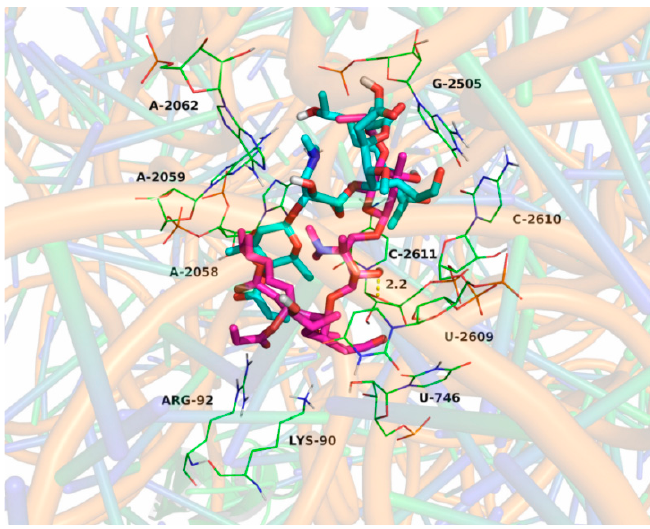
Figure 4. Overlapped conformation of the midecamycin A 1 (rose red sticks) and meleumycin D (cyan sticks) in the binding site of the